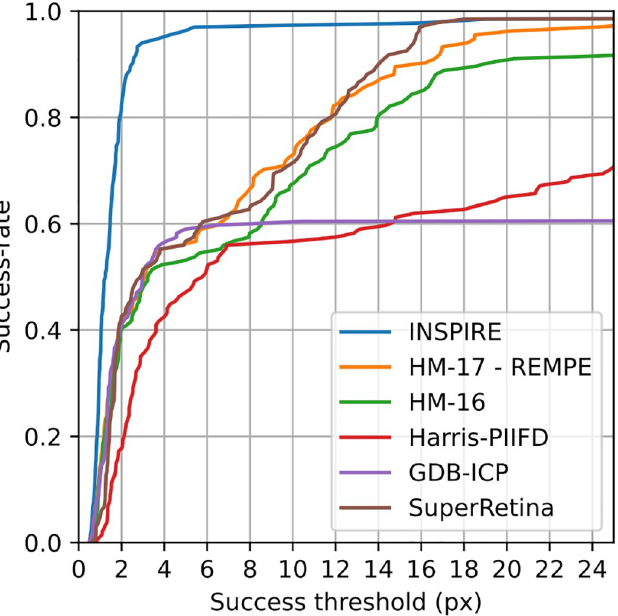
Fig 6. Results of retinal image registration on the FIRE dataset. The x -axis represents a range of error thresholds in pixels and the y -axis represents the fraction of registrations succeeding at each threshold level, where a registration is considered a success if the error (measured as the mean Euclidean distance between the ground-truth landmarks after registration) is below that threshold. We observe that INSPIRE exhibits excellent performance; 80% of the registrations have an error of 2 px or less, and only one single registration failed completely.